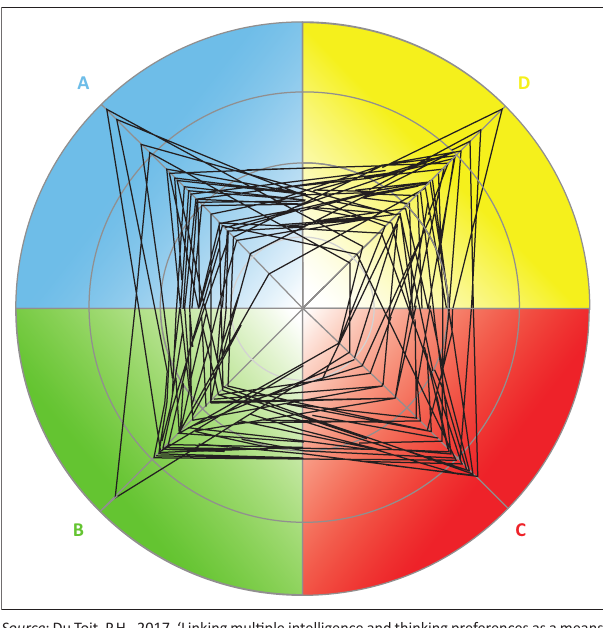
FIGURE 3: Composite group profile of a group of Postgraduate Certificate in Higher Education (PGCHE) students.